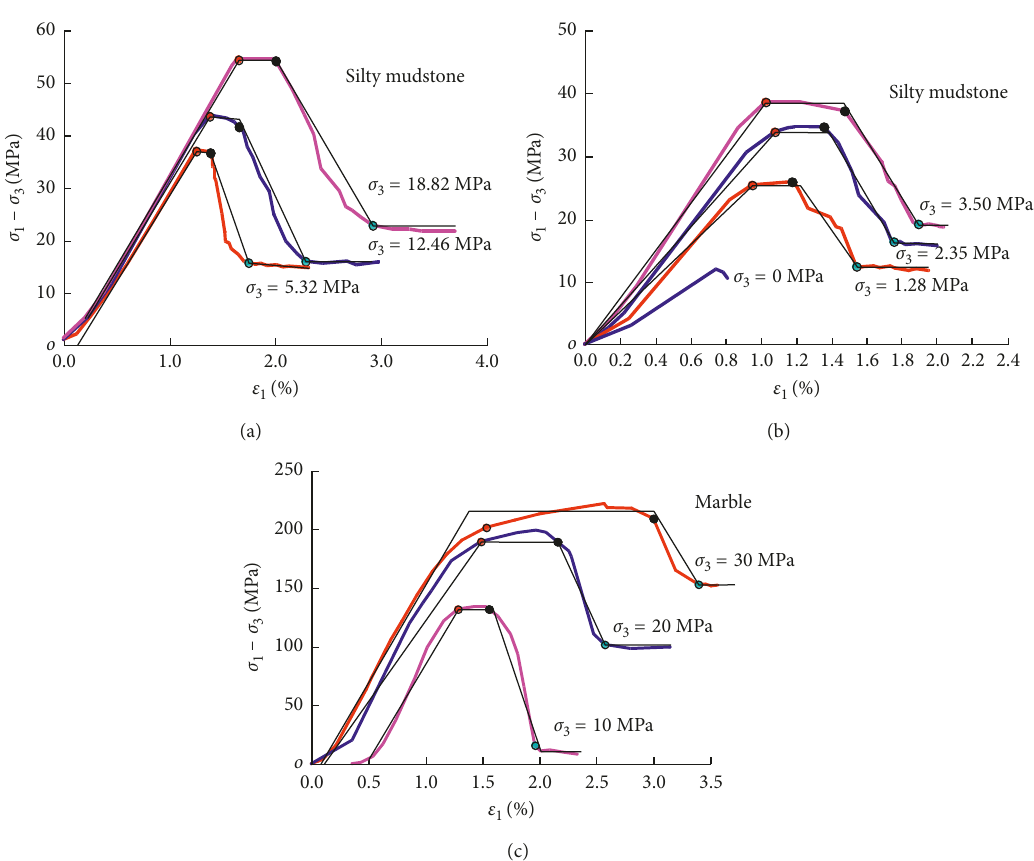
Figure 2: Total stress-strain curve of rock mass in the local area of China: (a) Yangzhuang coal mine in Henan Province; (b) Wushan area of Chongqing; (c) Ya’an area of Sichuan.